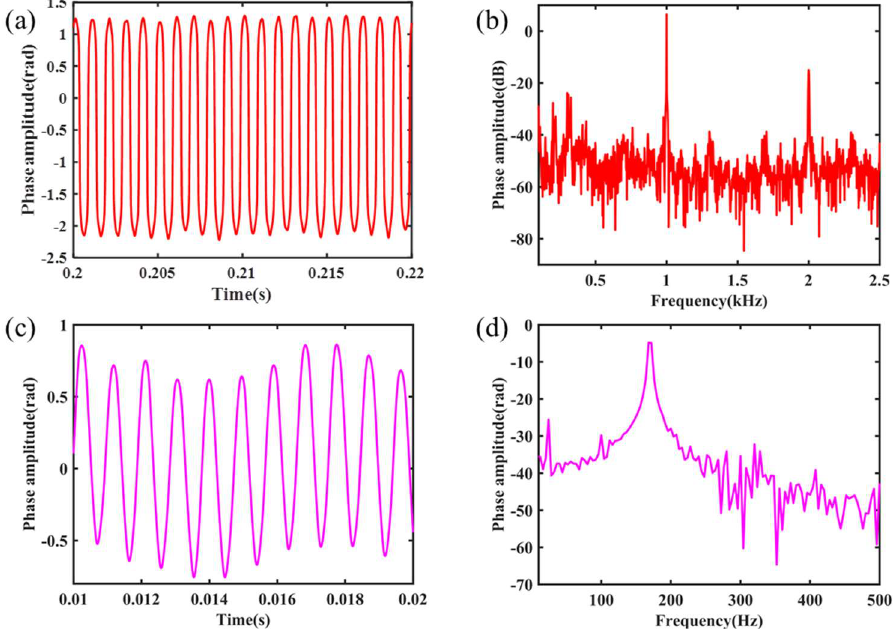
Figure 8. The demodulation signal of the 1 kHz simulating acoustic signal in ( a ) time domain and ( b ) frequency domain; the 170 Hz simulating acoustic signal in ( c ) time domain and ( d ) frequency domain.